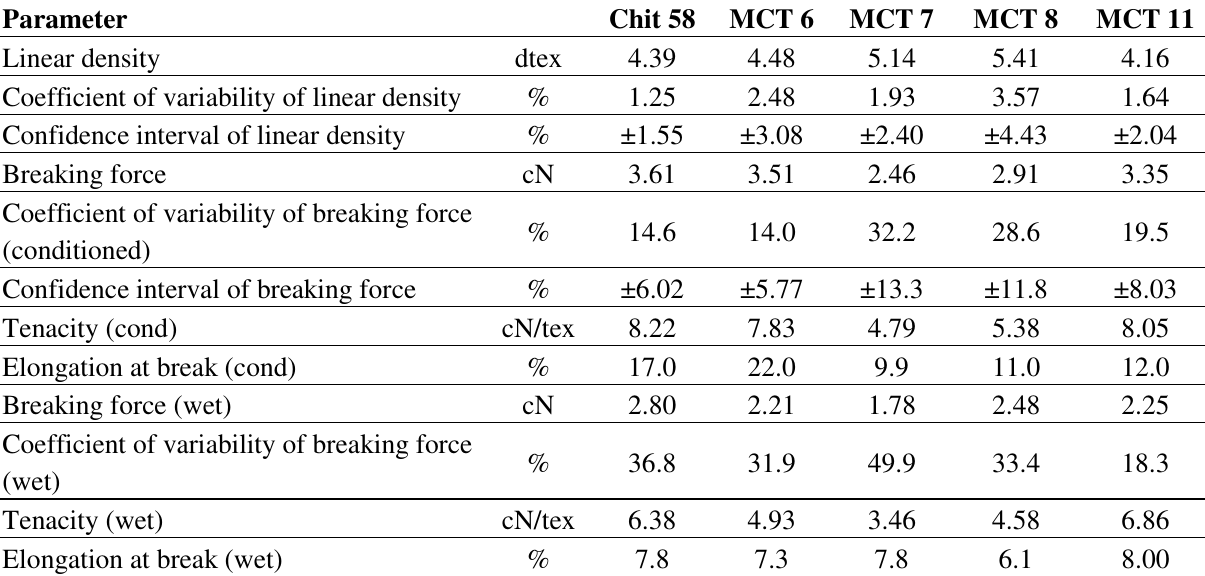
Table 3. Impact of HAp, β -TCP and HAp/ β -TCP concentration in the chitosan solution on the mechanical properties of